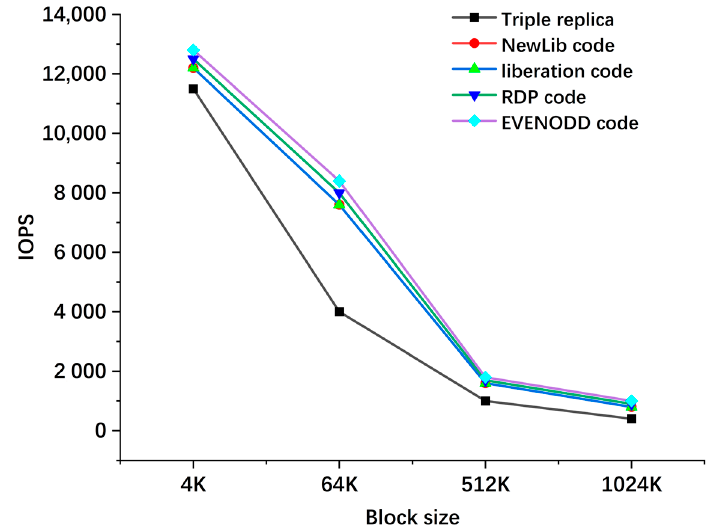
Figure 13. The IOPS in the sequential writing.